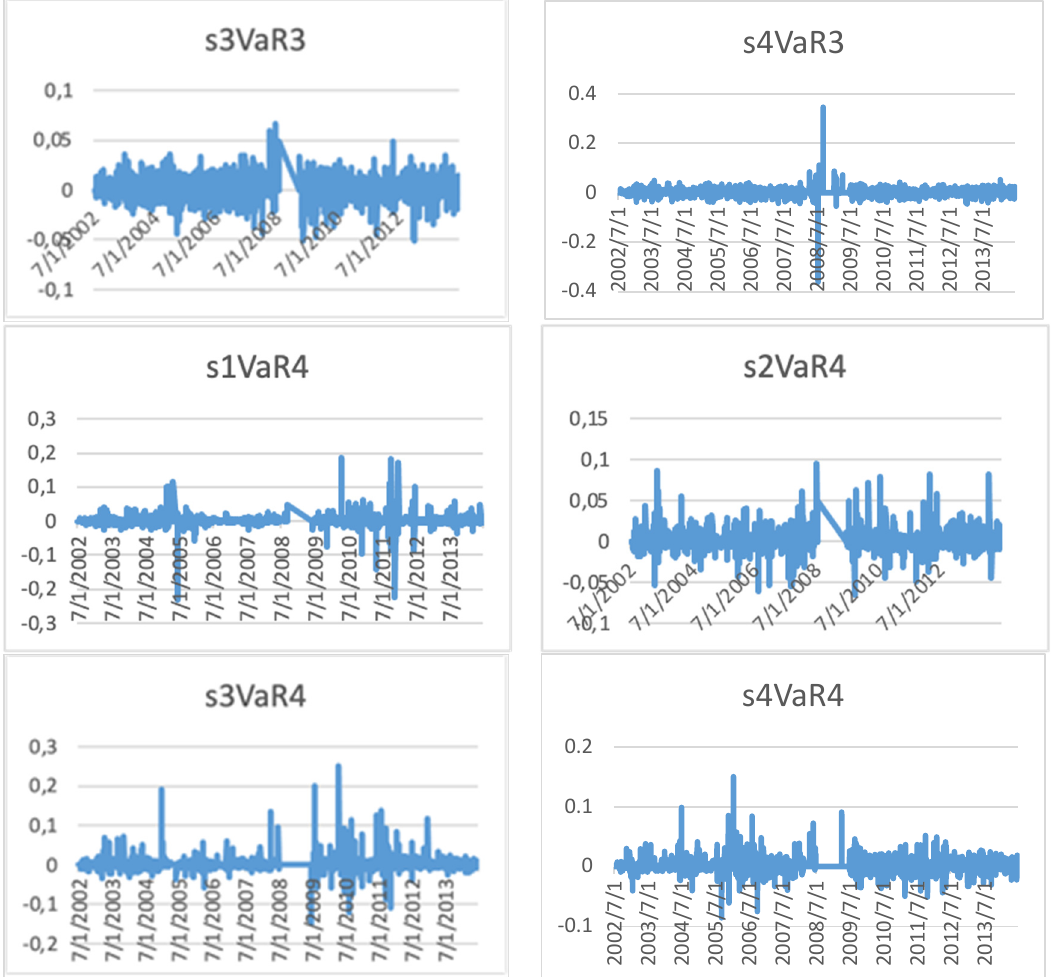
Figure A3. Daily Portfolios’ Returns of Size (S) and VaR (VaR1 Represent the Lowest Value at Risk Portfolio Quantile and VaR4 Represent the Highest Value at Risk Quantile) Factor (95% Level of Confidence).